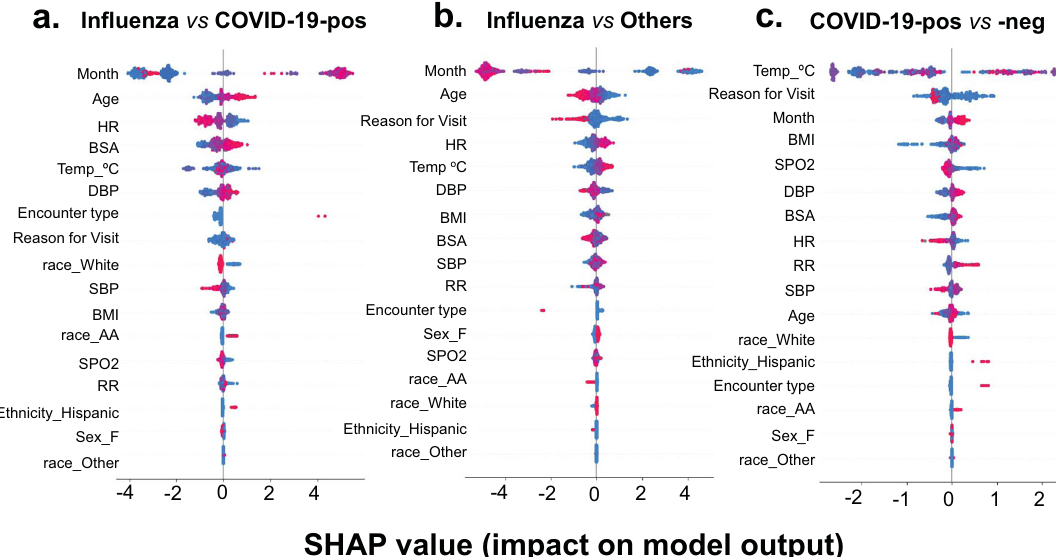
Fig. 3 SHapley Additive exPlanations (SHAP) beeswarm summary plot of SHAP values distribution of each feature of the test dataset. The plot depicts the relative importance, impact, and contribution of different features on the output of a in fl uenza vs COVID-19-positive, b in fl uenza vs other, and c COVID-19-positive vs COVID-19-negative predictive models. The summary plot combines feature importance with feature effects. The features on the y -axis are ordered according to their importance. Each point on the summary plot is a SHapley value for a feature and an instance (i.e., a single patient encounter in this case) in the dataset. The position of each point on the x -axis shows the impact that feature has on the classi fi cation model ’ s prediction for a given instance. The color represents the high (red) to low (blue) values of the feature (i.e., Age, BMI